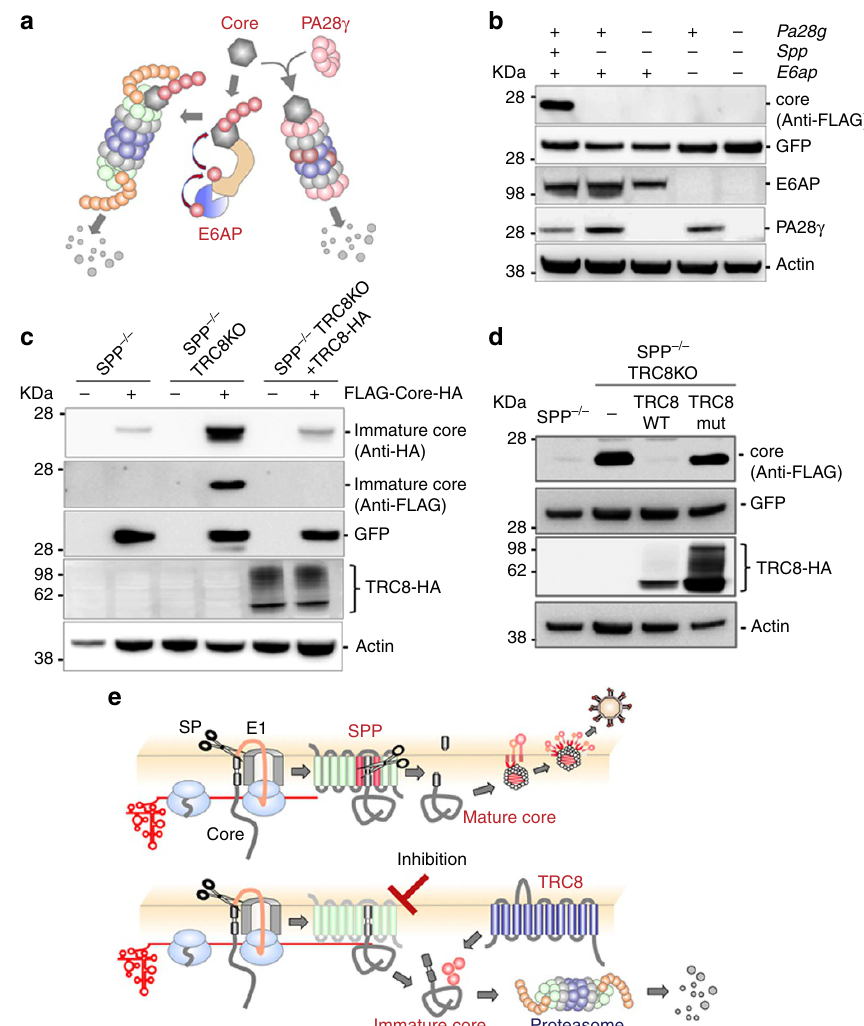
Figure 6 | TRC8-dependent proteasome degradation of the immature core protein in SPP-deficient cells. ( a ) Schematic representations of two distinct pathways of HCVcore protein degradation. The mature core protein interacts with PA28 g in the nucleus and is degraded by the proteasome independent of ubiquitin 52 . In contrast, E6AP can also bind to the mature core protein in the perinuclear region. E6AP ubiquitinates the core protein and degrades it in an ubiquitin-dependent manner 34 . ( b ) SPP/PA28 g /E6AP triple-knockout MEFs (SPP/PA28 g /E6APTKO) expressing FLAG-HCV core via lentivirus were subjected to immunoblotting at 48h post infection. ( c ) SPP (cid:2) / (cid:2) MEFs, SPP (cid:2) / (cid:2) TRC8KO MEFs and SPP (cid:2) / (cid:2) TRC8KO MEFs restored by HA-tagged TRC8 expression were infected with a lentivirus expressing FLAG-core-HA and subjected to immunoblotting. ( d ) SPP (cid:2) / (cid:2) and SPP (cid:2) / (cid:2) TRC8KO MEFs complemented with TRC8-HA or TRC8mut-HA and expressing FLAG-core were subjected to immunoblotting. ( e ) Maturation of the HCV core protein by processing with SP and SPP (upper panel). SPP deficiency and treatment with an inhibitor for SPP induced the degradation of the immature core protein by the proteasome, mediated by the E3 ligase TRC8 (lower scheme). The data are representative of two independent